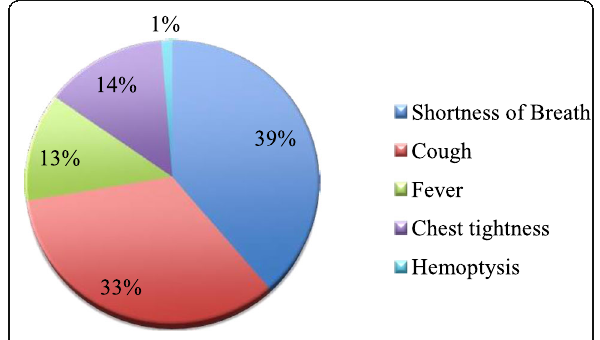
Fig. 5 Distribution based on dyspnea